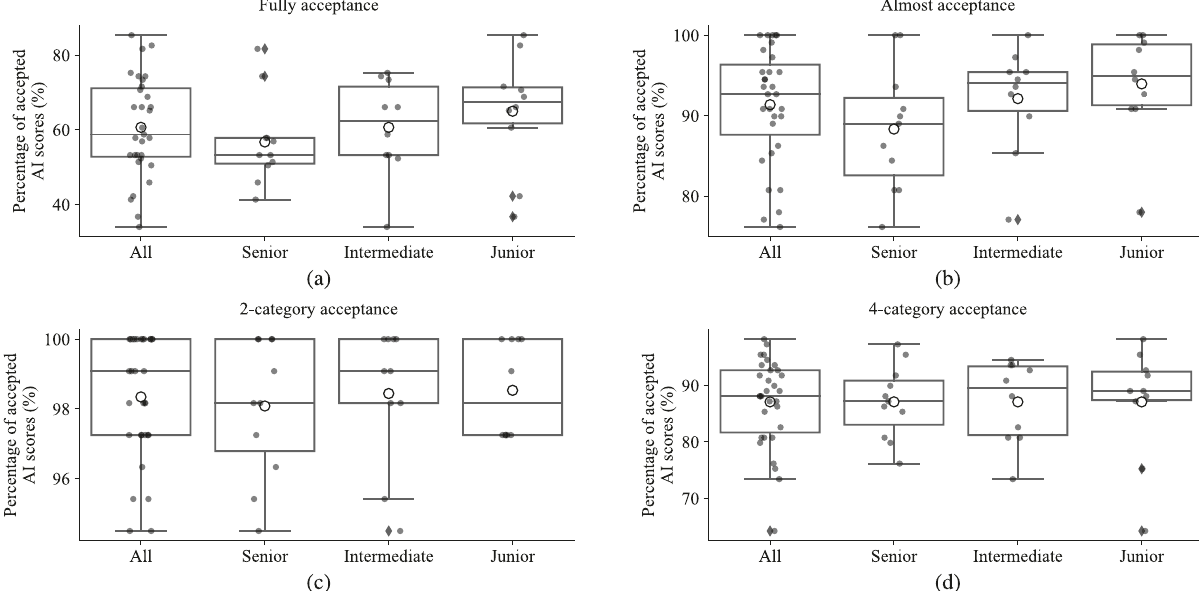
Fig. 5 Boxplots of acceptance of continuous and categorial AI scores. The center bar of each box represents the median value, and the box body extends from the 25th to the 75th percentile of values in one group. Black circles indicate the value of individual pathologists, and black diamonds indicate the outliers. The larger black circles with white inside indicate the average value of one group. a “ Fully accepted ” of continuous AI score with a scoring difference <1%. b “ Almost Acceptance ” of continuous AI score with scoring difference < 5%. c Acceptance of 2-category AI score. d Acceptance of 4-category AI